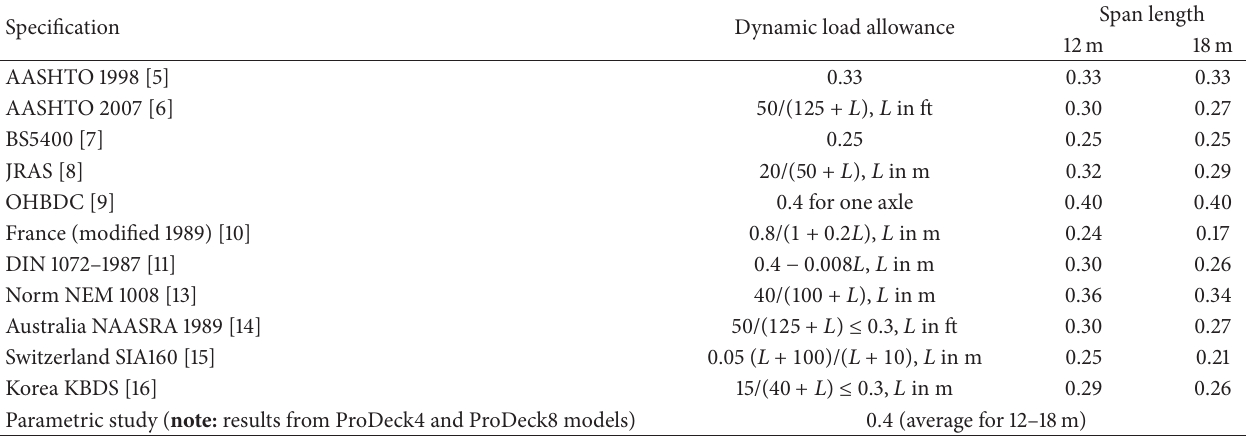
Table 4: Dynamic load allowance of various specifications.